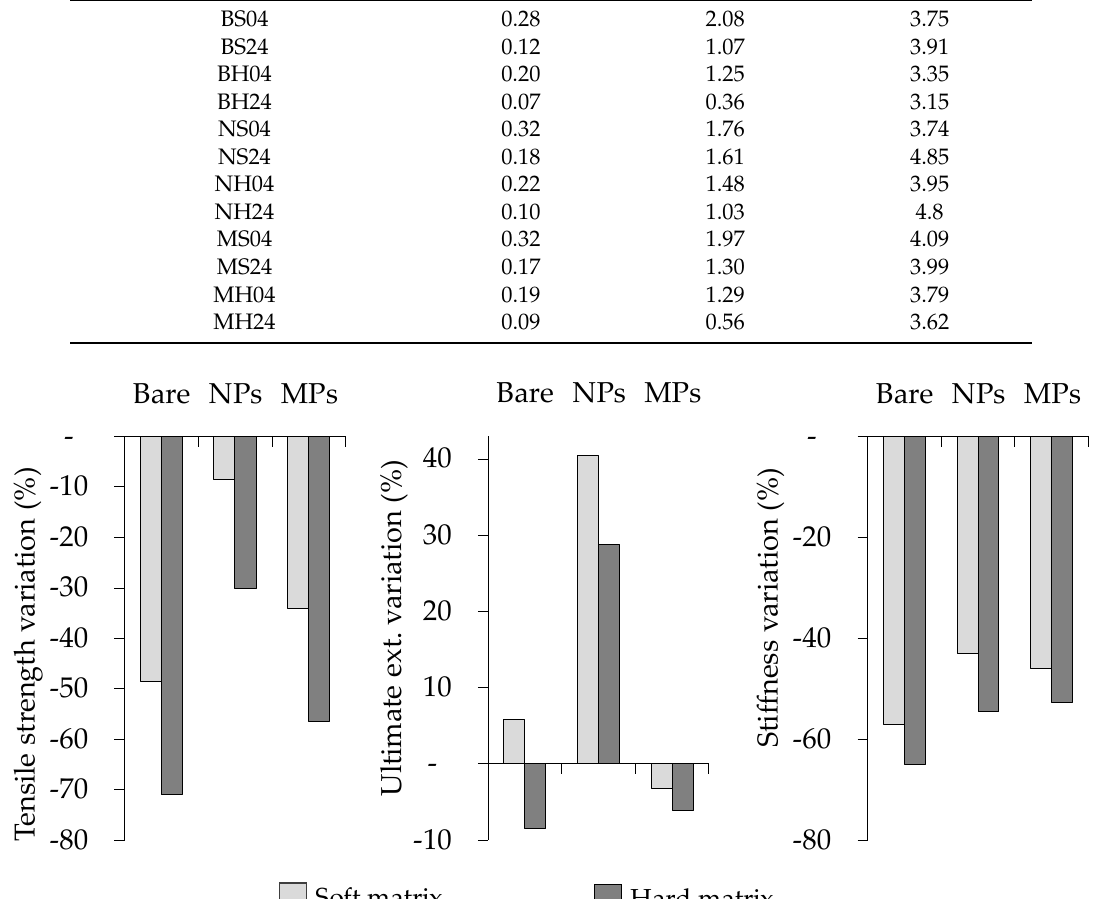
Figure 3. Mechanical properties variation of MRE samples when the SO content is increased from 4% to 24%. SO: silicone oil, NPs: nanoparticles, MPs: microparticles